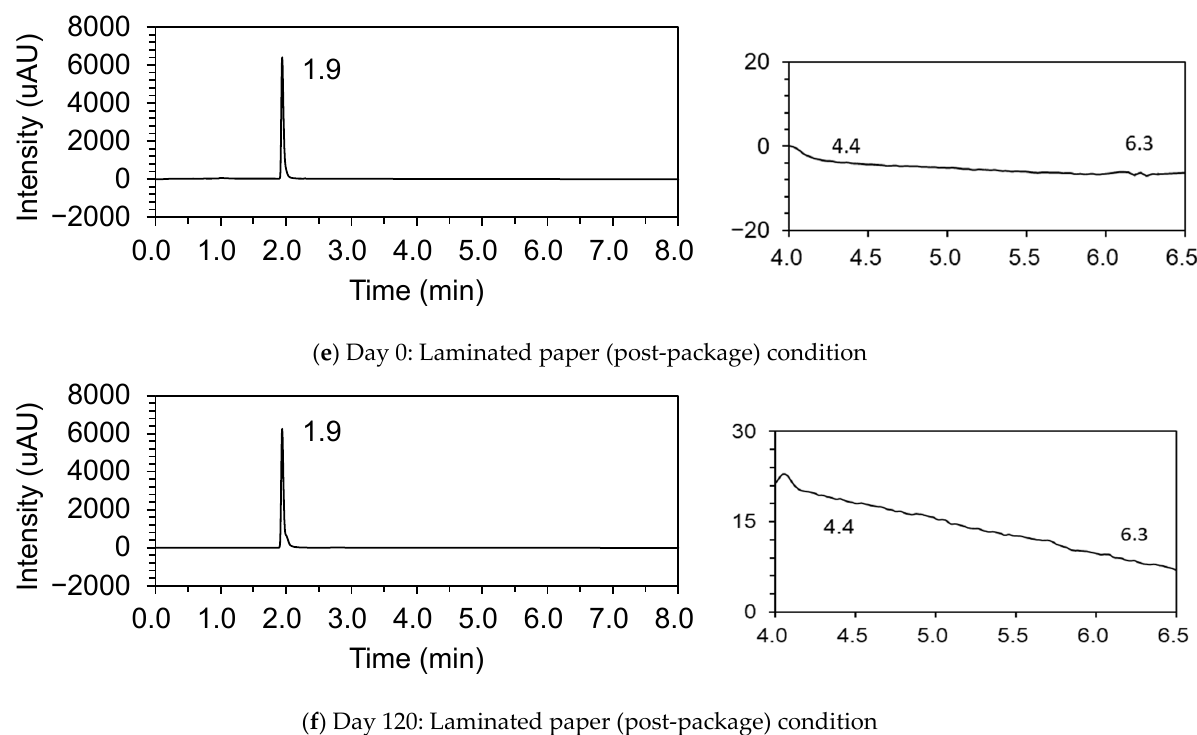
Figure 3. Dissolution profiles of compounded baclofen formula in water on days 0 and 120 in each ‘bottle (closed)’ ( a , b ), ‘bottle (in use)’ ( c , d ), and ‘laminated’ ( e , f ) condition. Enlarged chromatograms for confirmation of impurities A and B are shown to the right of each chromatogram. Each sample was examined with six replicates.